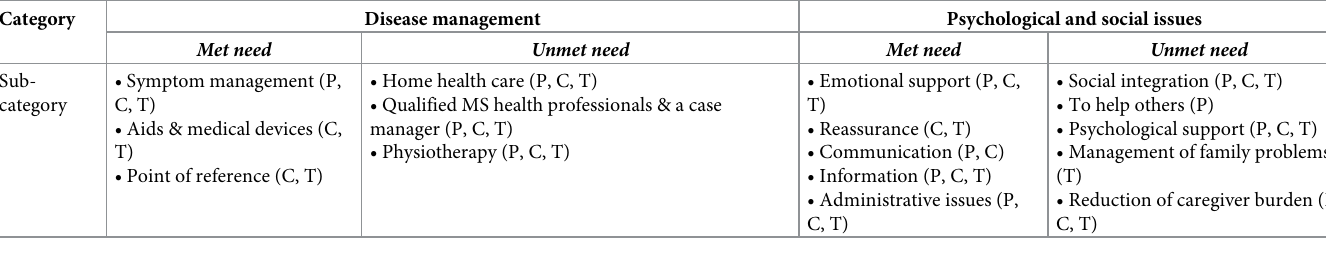
Table 4. The two needs categories (columns) and 16 sub-categories(rows) reported by participants.